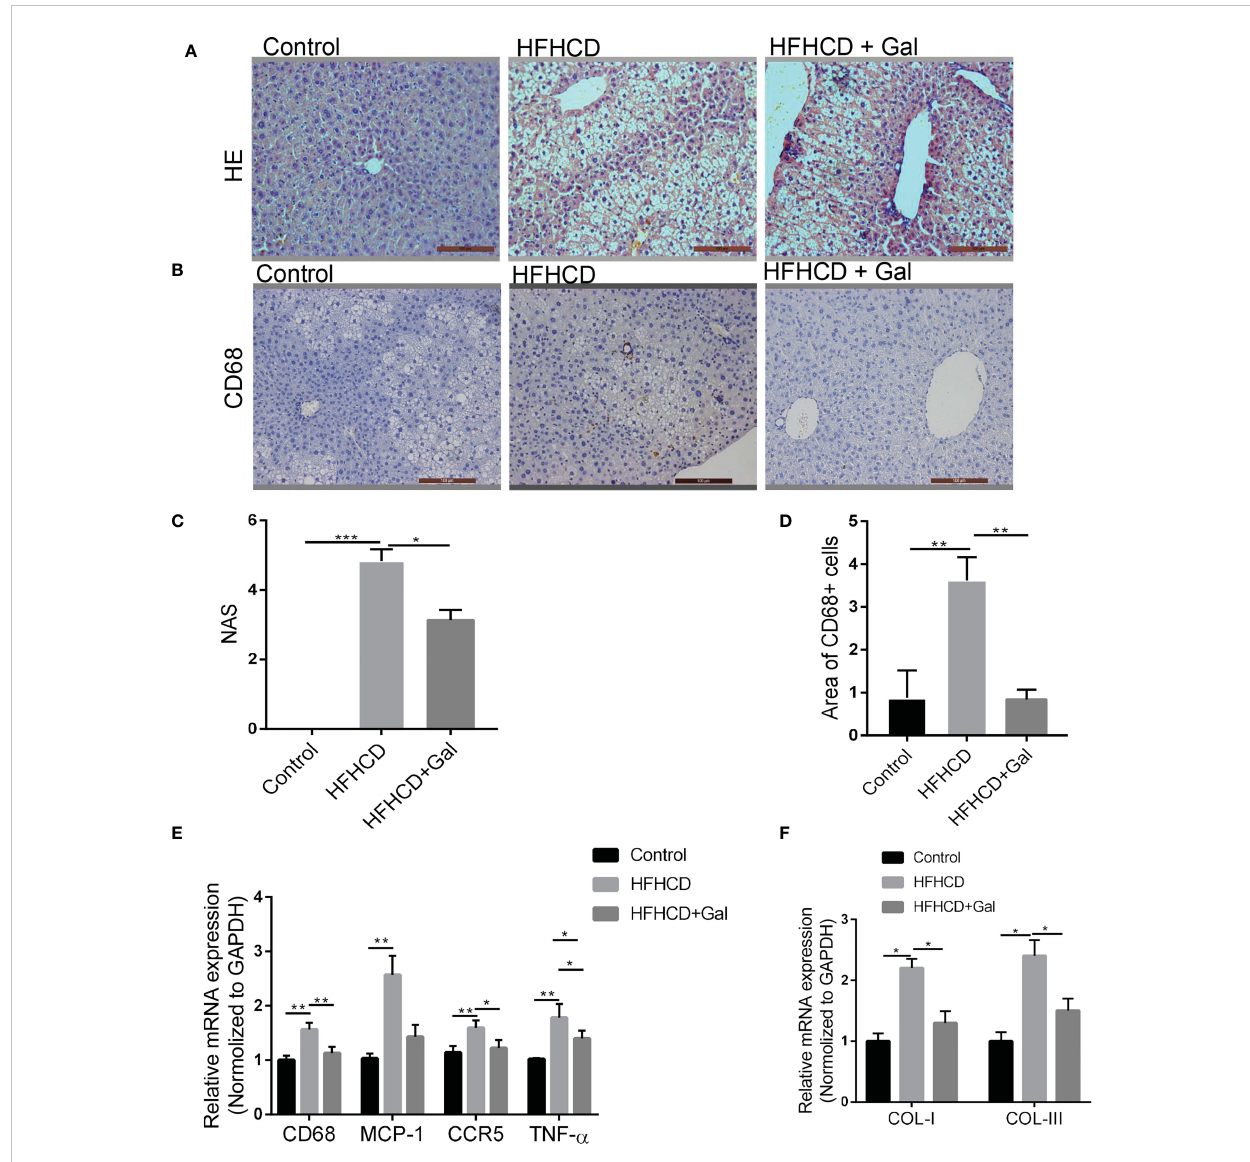
FIGURE 2 Galanin improves liver in fl ammation in HFHCD – fed mice. (A) HE staining on representative liver tissue sections from mice in each group. (B) Immunohistochemical analysis of CD68 on representative liver tissue sections from mice in each group. (C) NAS analysis using electron microscope; 6 sections per mouse were quanti fi ed. *, p < 0.05, ***, p < 0.001. (D) Quantitative analysis of (B) **, p < 0.01. (E) CD68, MCP-1, CCR5 and TNF- a mRNA levels of liver assessed by qRT-PCR. *, p < 0.05, **, p < 0.01. (F) Liver gene expressions of COL-I and COL-III in each group. *, p < 0.05. HE, Hematoxylin-eosin staining; NAS, NAFLD activity score; CCR5, C-C chemokine receptor type 5; TNF- a , Tumor necrosis factor- a ; GAL,